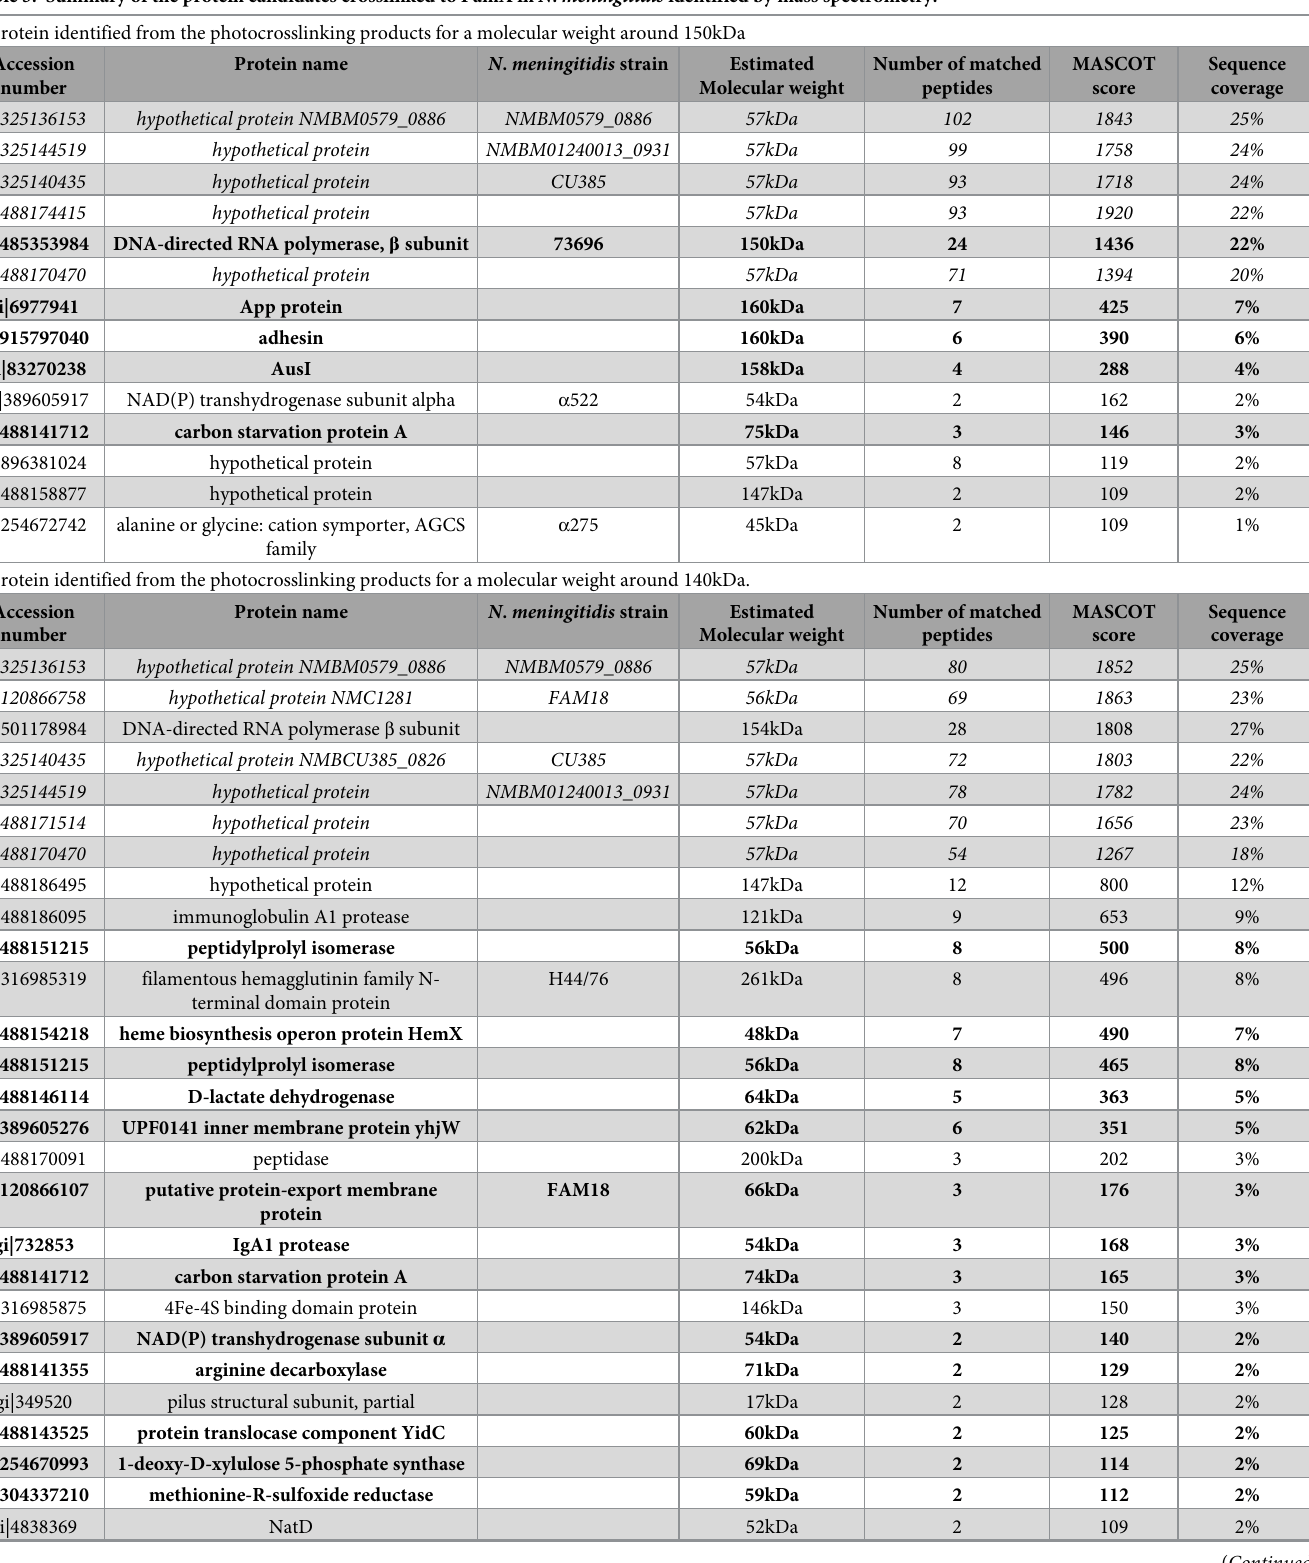
Table 3. Summary of the protein candidates crosslinked to PamA in N . meningitidis identified by mass spectrometry. 1. Protein identified from the photocrosslinking products for a molecular weight around 150kDa